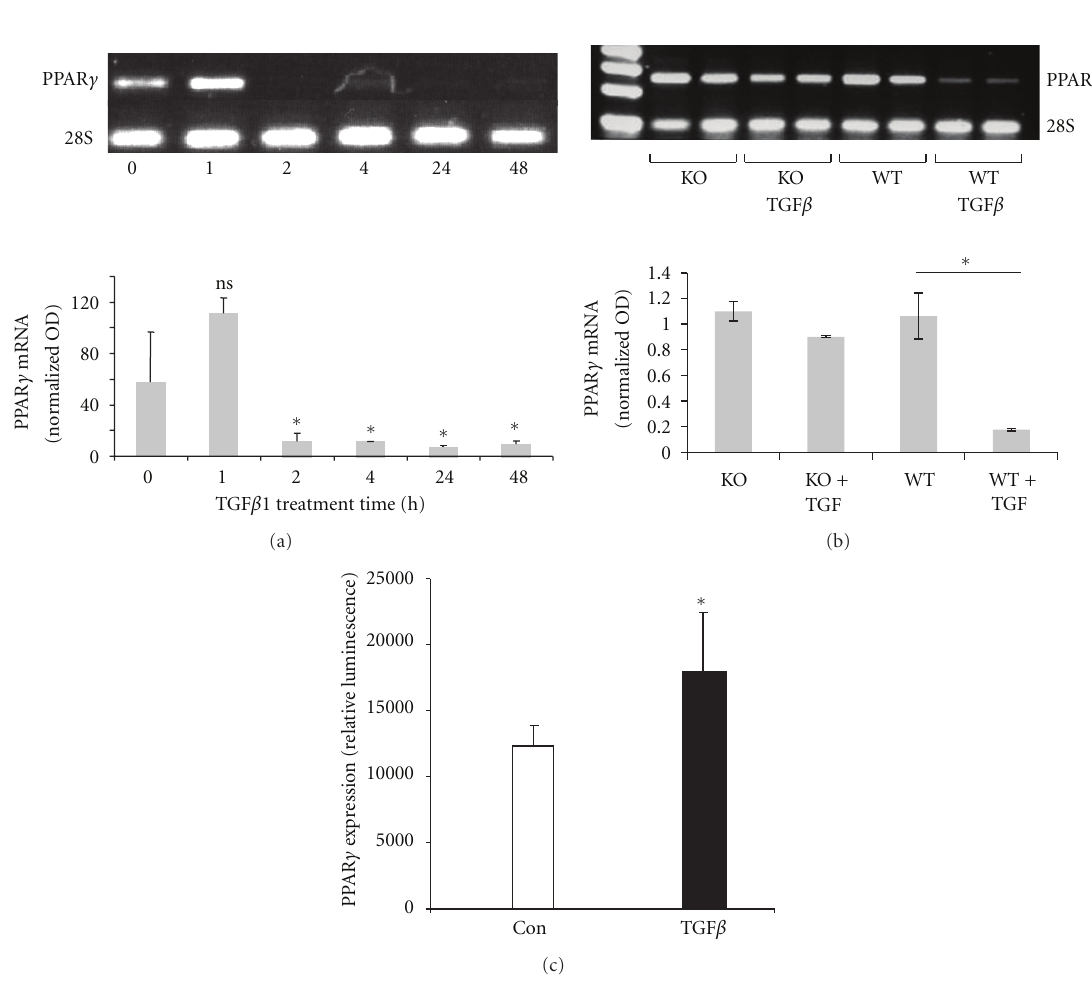
Figure 1: TGF β 1 modulates PPAR γ expression, in part, via Smad3 signaling. (a) TGF β 1 and PPAR γ mRNA expression. Murine primary lung fibroblasts were stimulated with TGF β 1 (10ng/mL) for the indicated times. The treated cells were then submitted for analysis by RT-PCR for PPAR γ . (b) Role of Smad3. Primary lung fibroblasts were isolated from the lungs of Smad3-deficient and wildtype mice and incubated with TGF β 1 (10ng/mL) for 24 hours. Transcripts of PPAR γ mRNA were detected using RT-PCR. ∗ P < 0 . 05. (c) Regulation of PPAR γ gene trans- cription. NIH/3T3 fibroblasts were transiently transfected with a luciferase reporter driven by the full-length PPAR γ promoter and incubated with TGF β 1 (10ng/mL). Cellular extracts were analyzed after 24 hours for luminescence. Luciferase activity was normalized to Renilla with data shown as fold change ± SE relative to control. ∗ P < 0 .